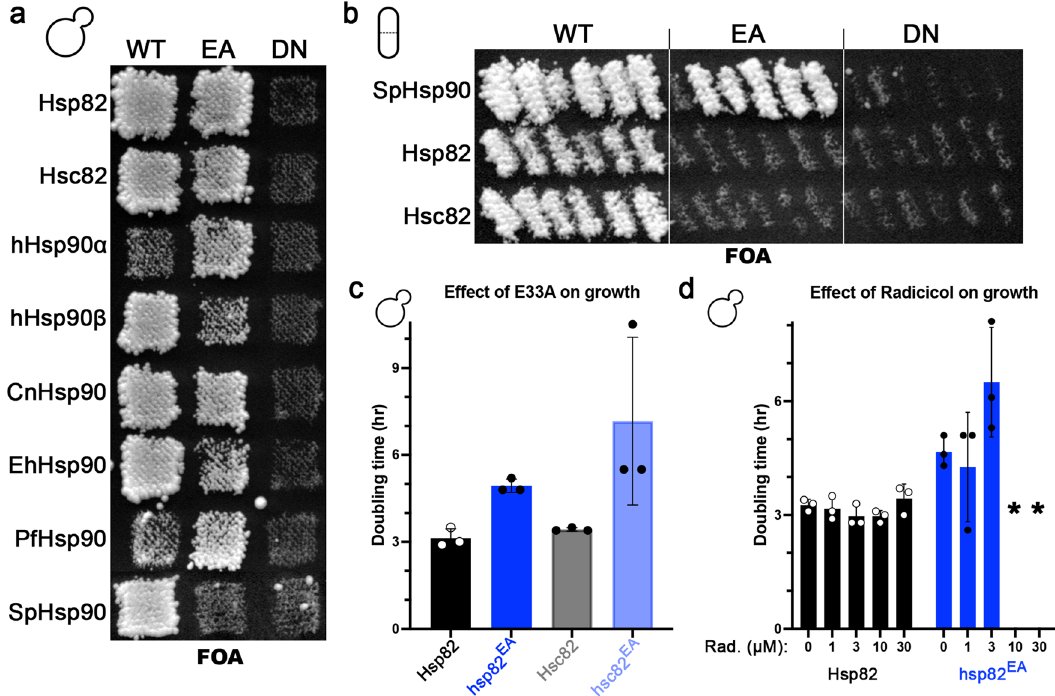
Fig. 1 | ATP hydrolysis, but not binding, is dispensable for viability of S. cere- visiae or Sz.pombe .a Plasmidshuf fl ein S.cerevisiae (buddedcell).Hsp90sfrom S. cerevisiae (Hsp82, Hsc82), human (hHsp90 α and hHsp90 β ), C. neoformans (CnHsp90), E. histolytica (EhHsp90), P. falciparum (PfHsp90) and Sz. pombe (SpHsp90) complemented the essential function of S. cerevisiae Hsp90 (left col- umn, wt), as denoted by uniform growth of patches on FOA plates. The hydrolysis defective (EA) versions of all the Hsp90s except SpHsp90 also complemented S. cerevisiae Hsp90 essential function (middle column). None of the nucleotide binding defective (DN) Hsp90s could support S. cerevisiae viability (right column). b Plasmidshuf fl ein Sz.pombe ( fi ssioncell).Thehydrolysisdefective(EA)versionof